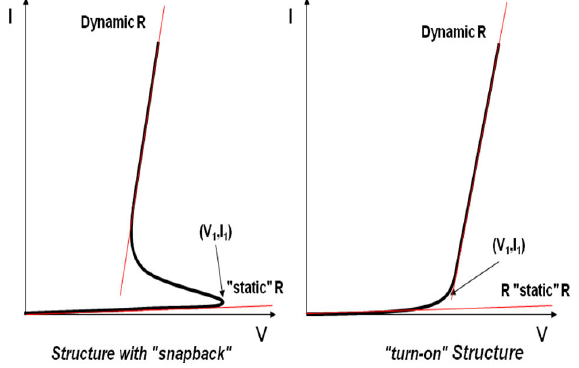
Figure 3: Representative I/V observed on IC